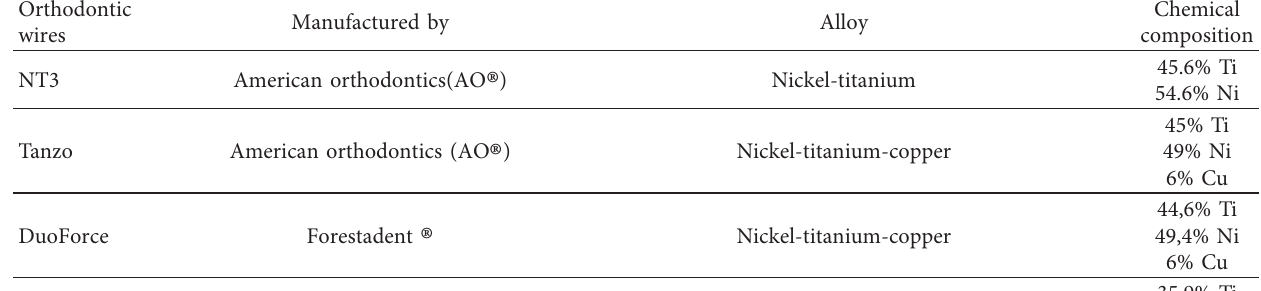
Table 1: Archwires used in the